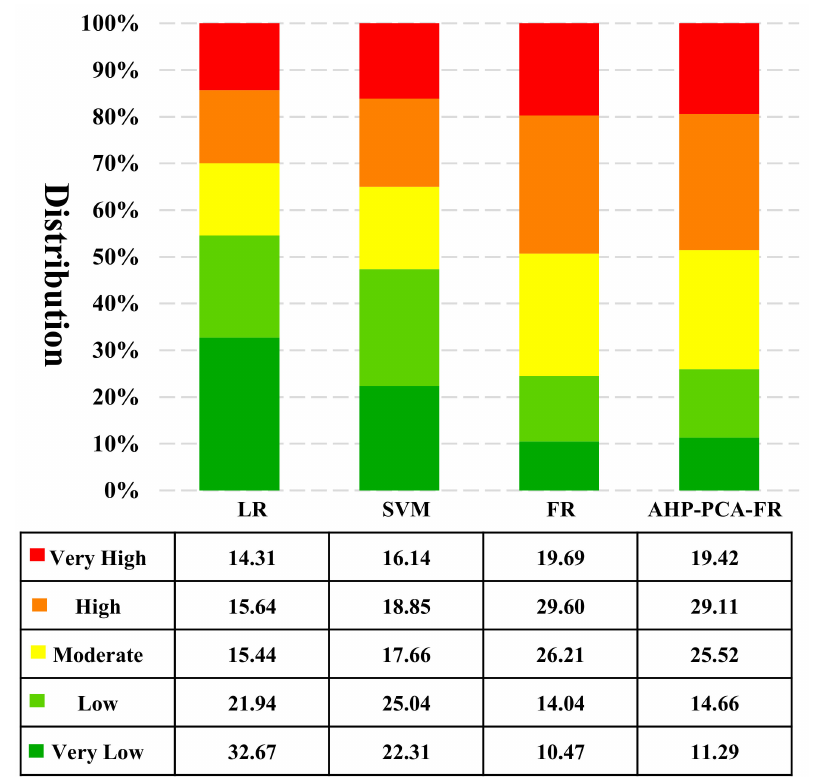
Figure 10. Distribution of the different debris flow susceptibility classes from the four